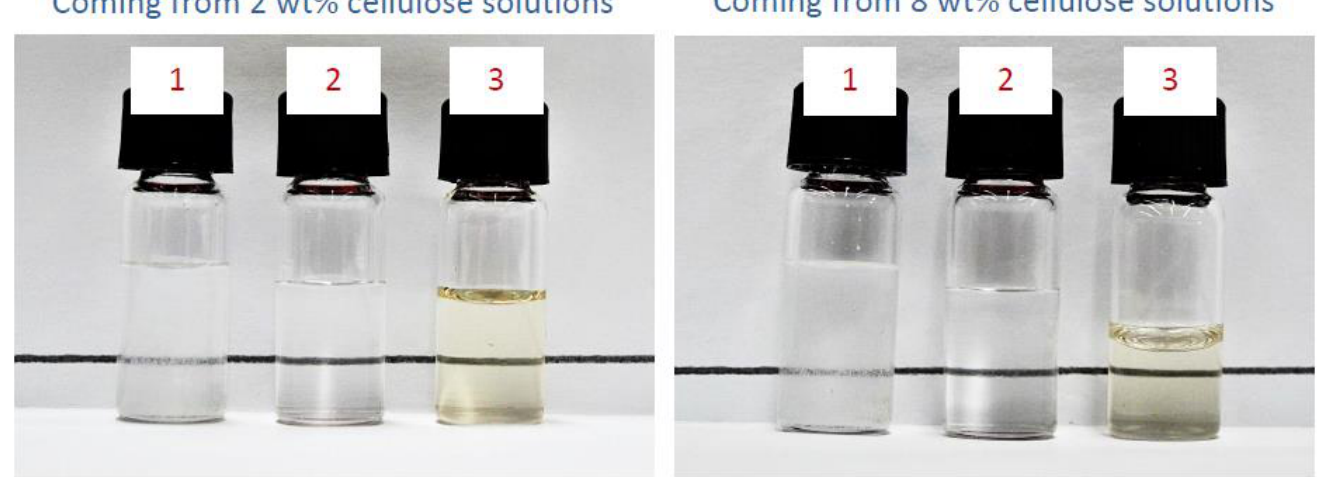
Figure 1. Picture of the supernatant phase obtained after addition of H 2 O at 20 °C (1), H 2 O at 4-5 °C (2), or AcOH at either 20 or 60 °C (3) to EMIMCl solutions with 2 wt% ( left ) and 8 wt% ( right